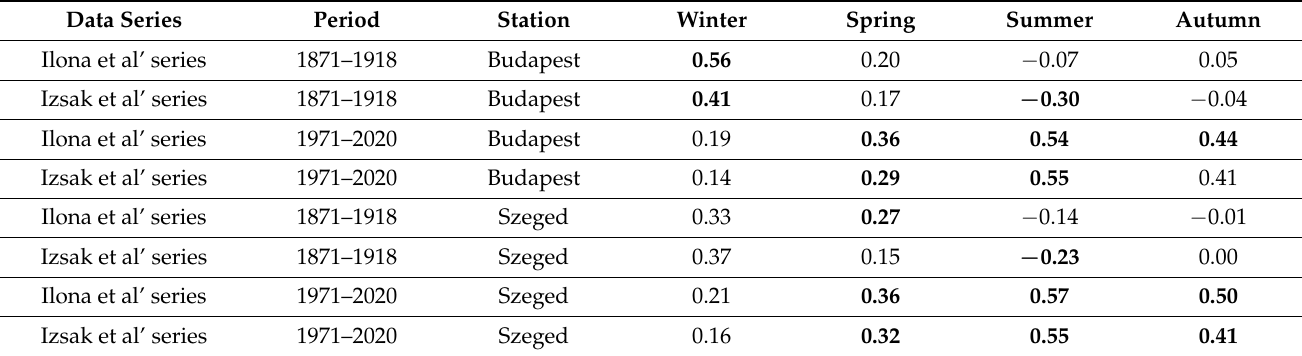
Table 7. Comparison of trends of 24 h temperature ( ◦ C/decade) for historical (1871–1918) and current (1971–2020) periods calculated in this study (Ilona et al.) and from Izsak et al.’s [16] homogenized time